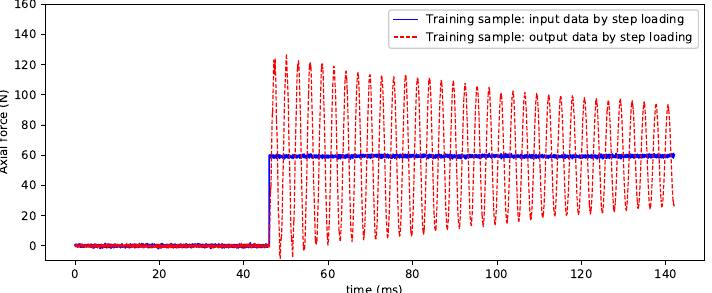
Figure 7. Ideal step loading (output data) and unloading (input